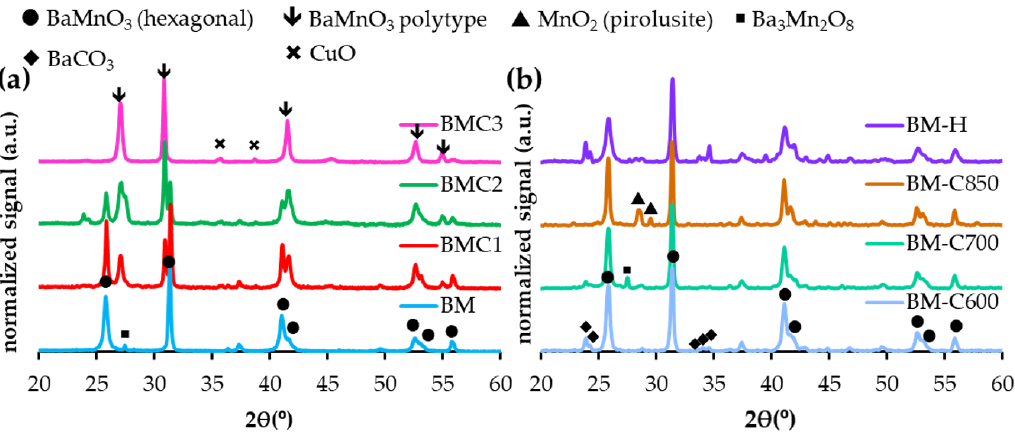
Figure 1. X-ray patterns of ( a ) BaMn 1 − x Cu x O 3 series and ( b ) BaMnO 3 catalysts. For the perovskites obtained through conventional sol-gel synthesis, the crystal phases detected depended on the amount of copper. BM, the sample without copper, presented as the main crystal phase the BaMnO 3 hexagonal (PDF number: 026-0168), and for the BaMn 1 − x Cu x O 3 series, as the copper content increased, the hexagonal phase decreased